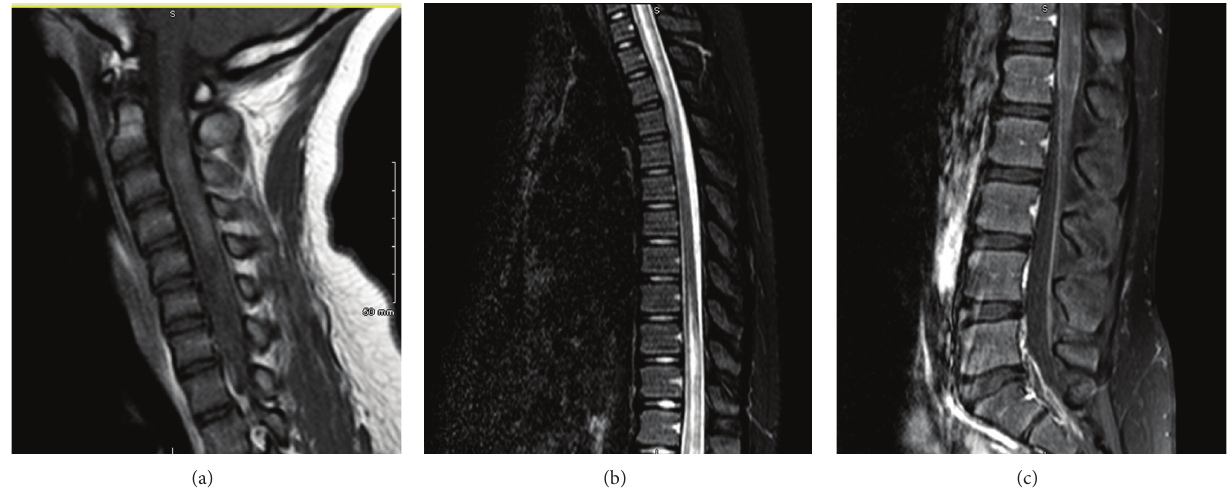
Figure 2: MRI of the cervical spine: (a) T1W postcontrast shows increased cord signal with an enlarged, edematous central cord. MRI of the thoracic spine: (b) T2W STIR shows abnormal T2 signal within the cord. MRI of the lumbar spine: (c) T1W postcontrast with fat suppression shows abnormal enhancement in the